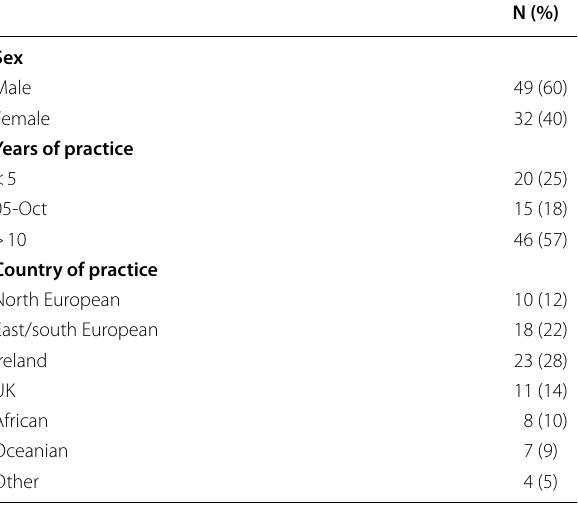
Table 1 Demographics of respondents in the survey